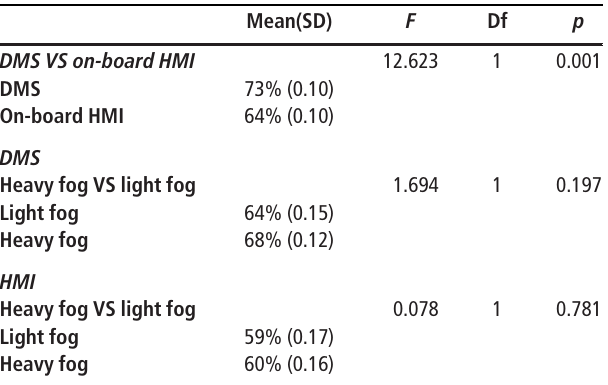
Table III Analysis results of the effect of technology types and fog density